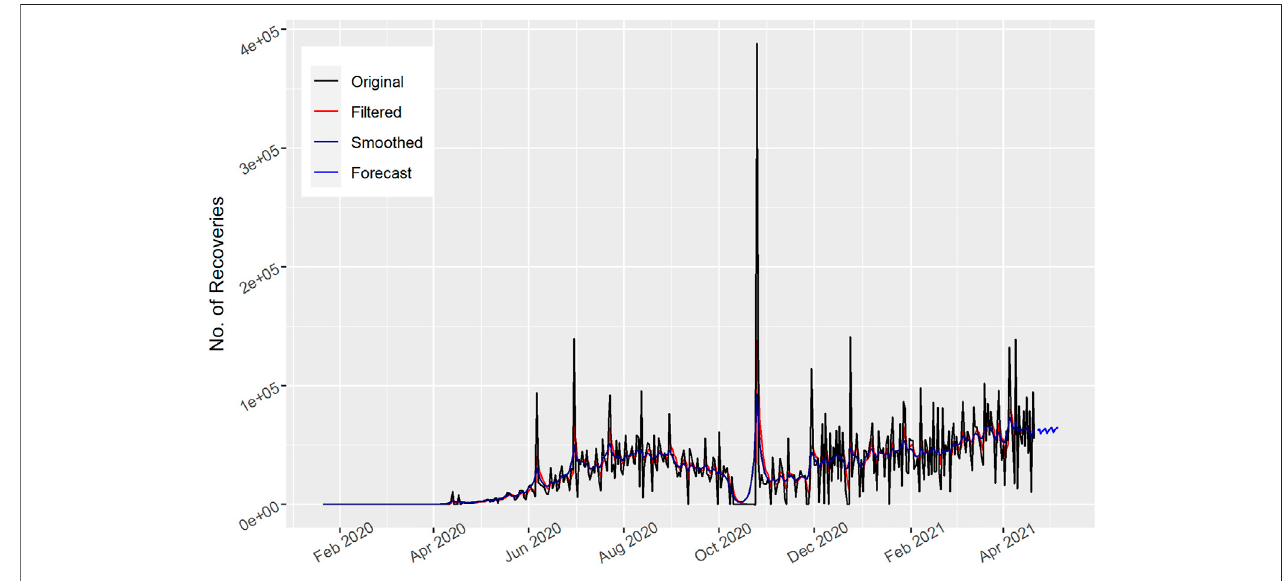
FIGURE 11 | Number of daily recovered cases of Brazil.